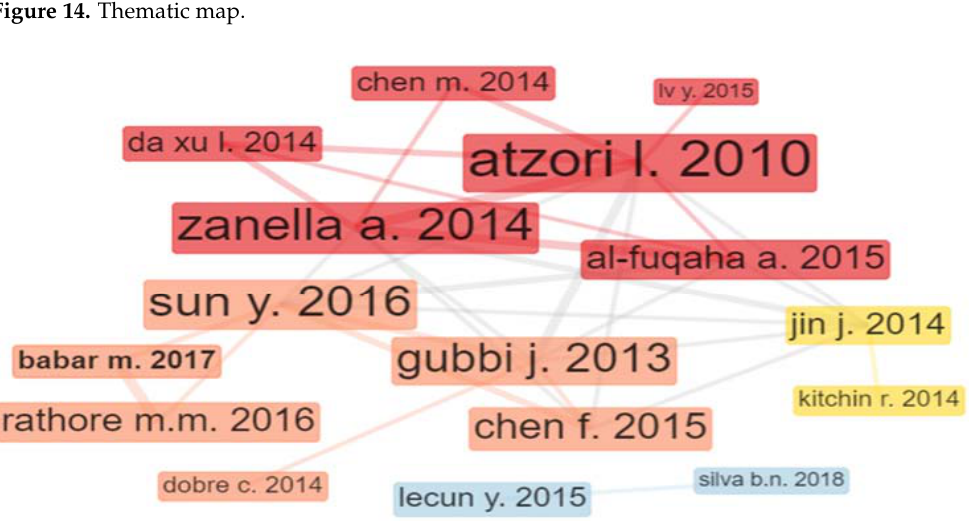
Figure 15. Co-citation network.